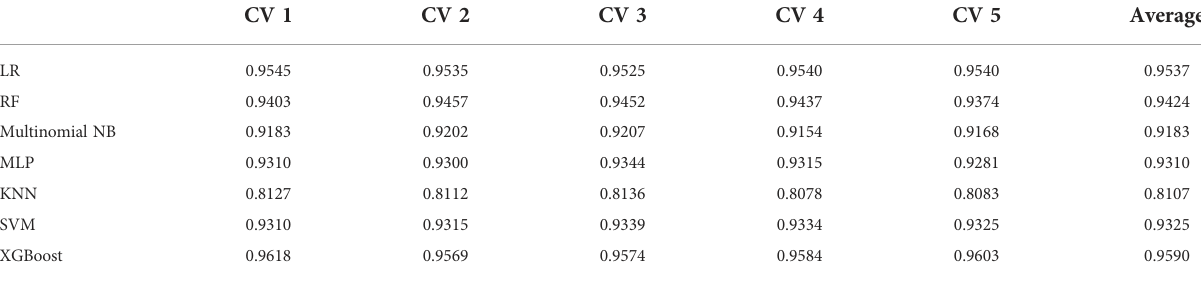
TABLE 3 The results of 5-fold cross-validations with the 1 – 3-gram language model.